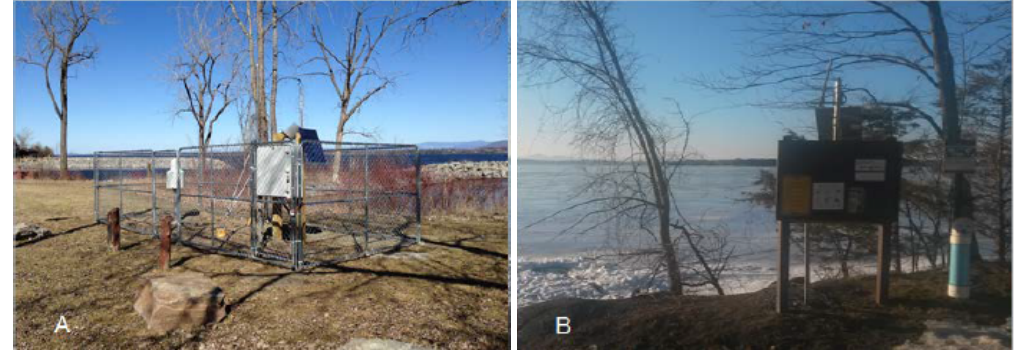
Figure 8. Limnimetric stations installed at ( A ) and ( B ) on Lake Champlain (site 1) ( © The International Joint Commission (IJC)). ( A ) Port Henry site; ( B ) Grand Isle